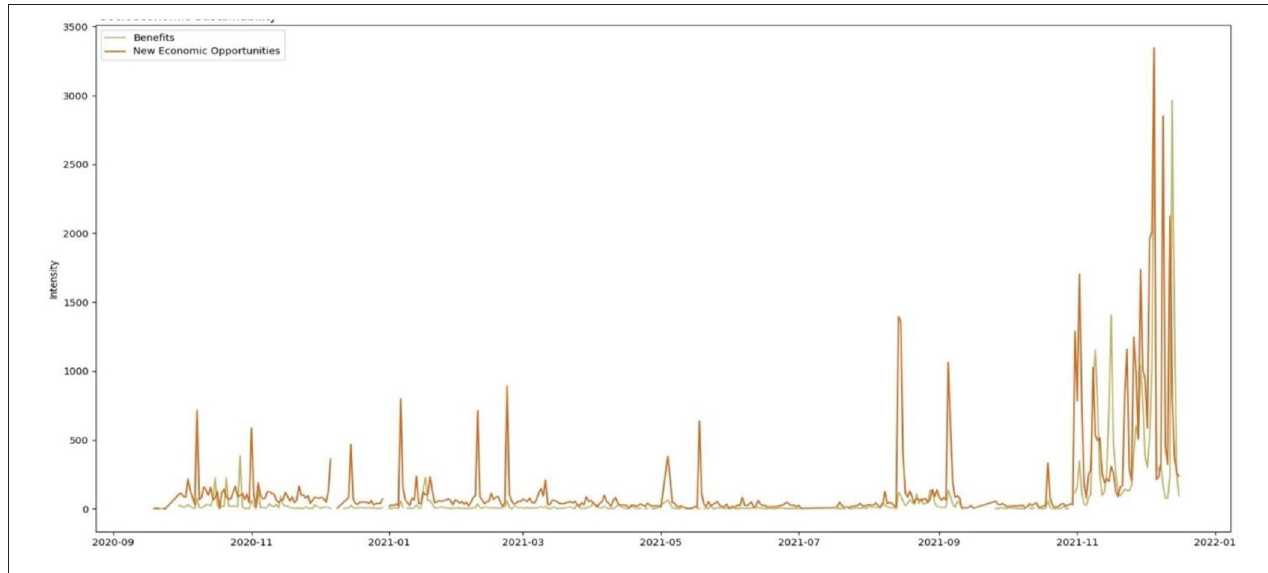
FIGURE 9 | Temporal progression of parameters (socioeconomic